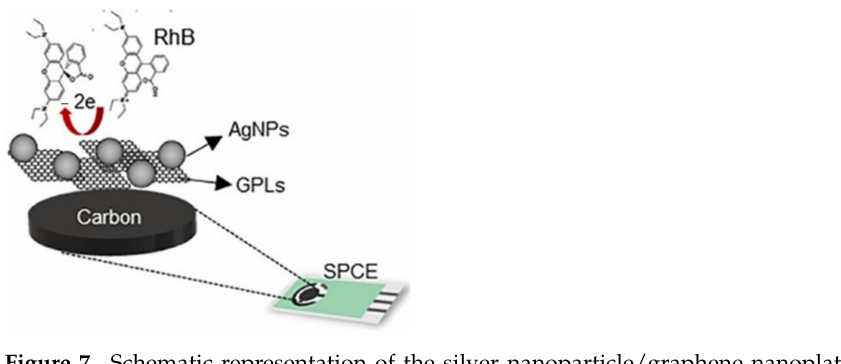
Figure 7. Schematic representation of the silver nanoparticle/graphene nanoplatelets modified screen-printed carbon electrodes. Reprinted (adapted) with permission from Ref. [68]. Copyright 2021, American Chemical